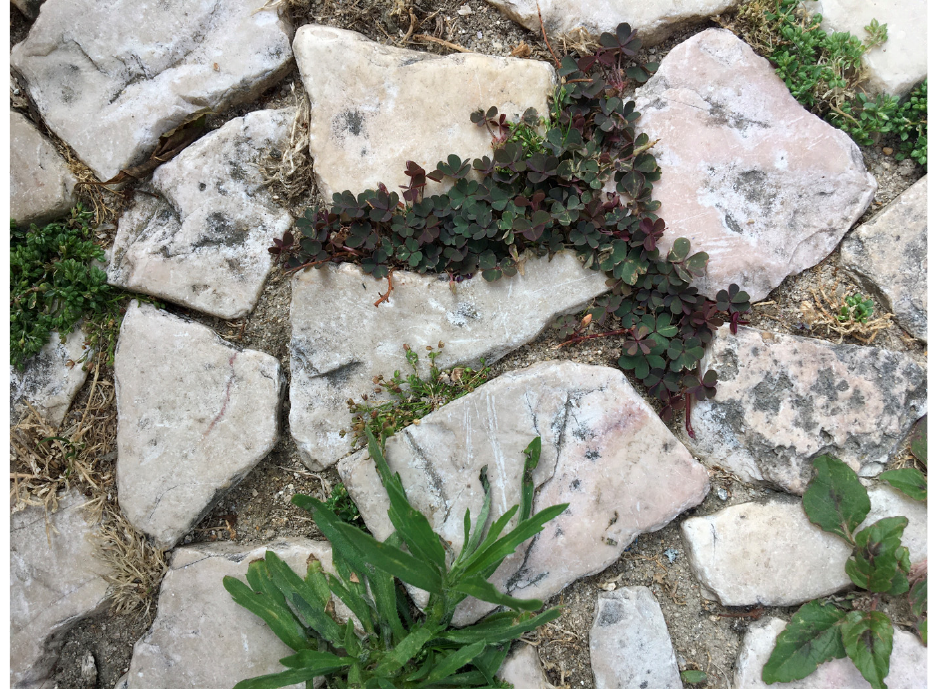
Figure 3. Ruderal plants growing in the cracks of a cobblestone pavement, Lisbon, Portugal, 2022 © Teresa Castro.